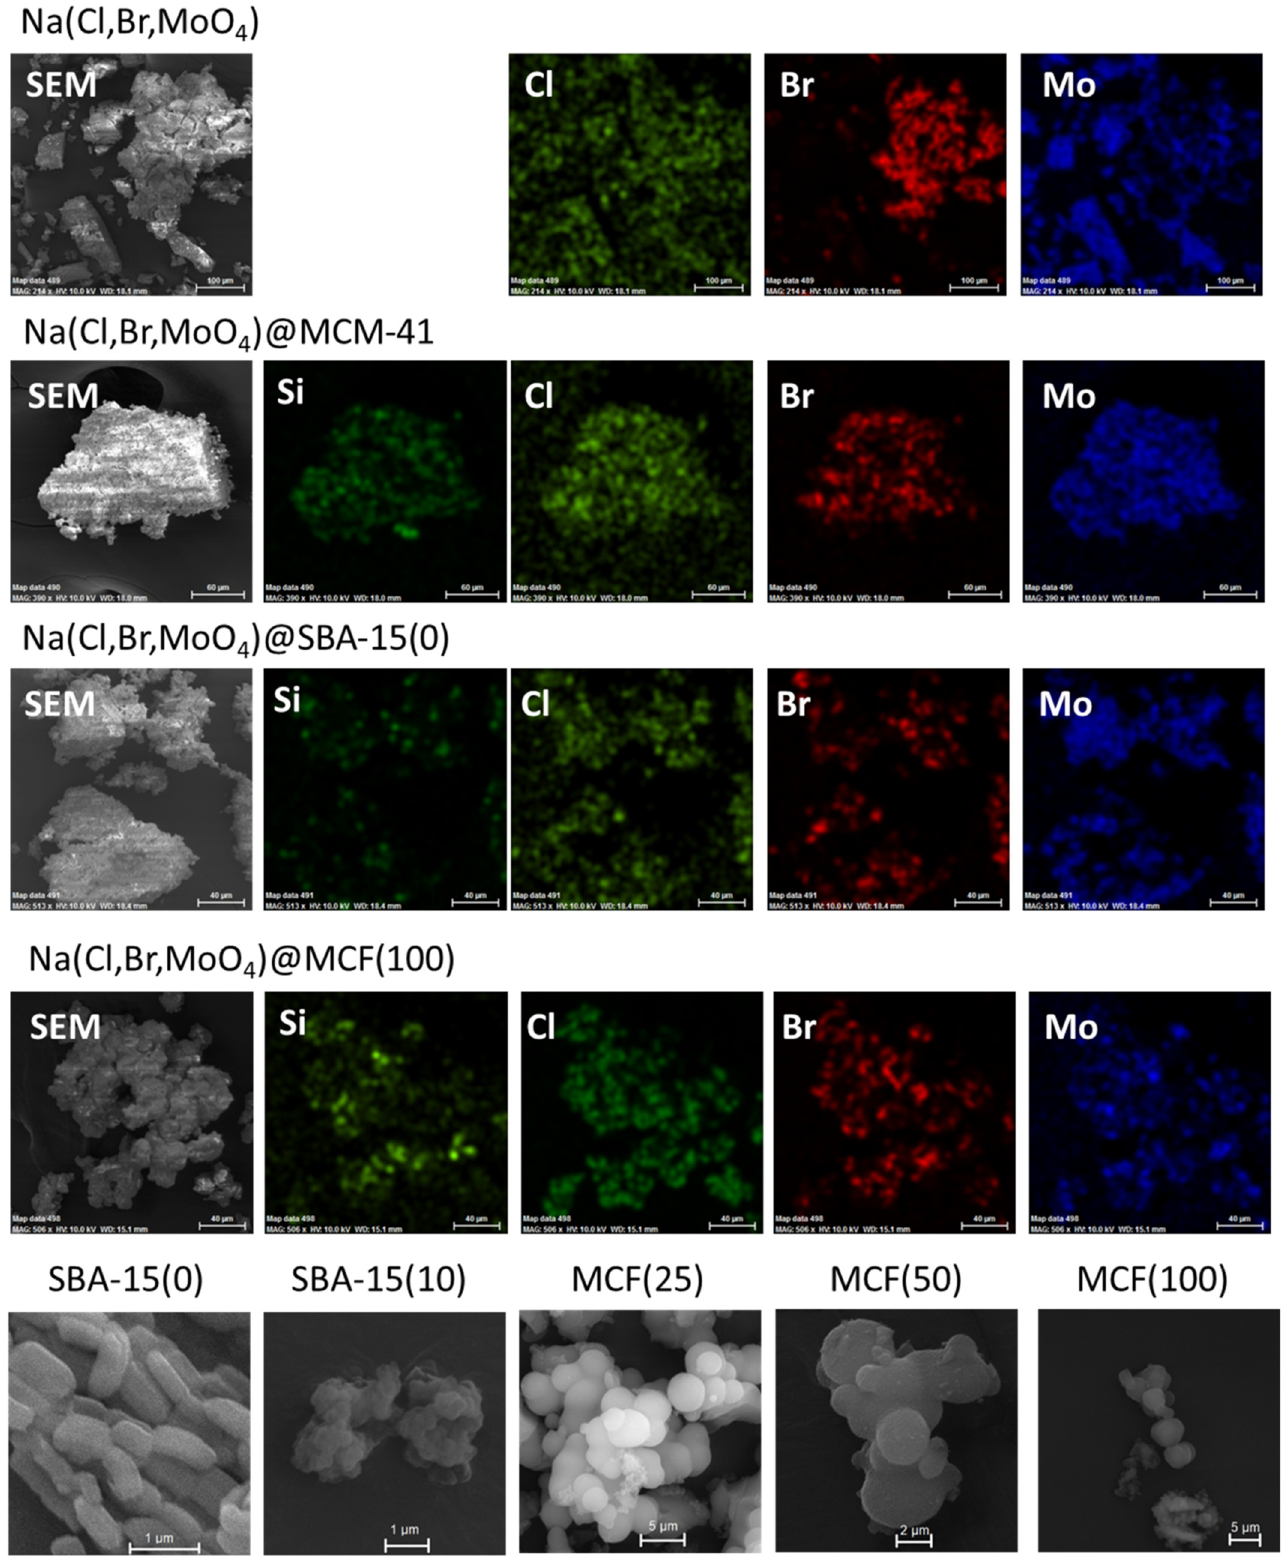
Figure 16. Scanning electron microscopy of silica matrices, ternary NaCl-NaBr-Na 2 MoO 4 molten salt and composites PCMs, as well as elemental distribution maps. Reproduced with permission from ref. [198]. Copyright Elsevier B.V. 2020.